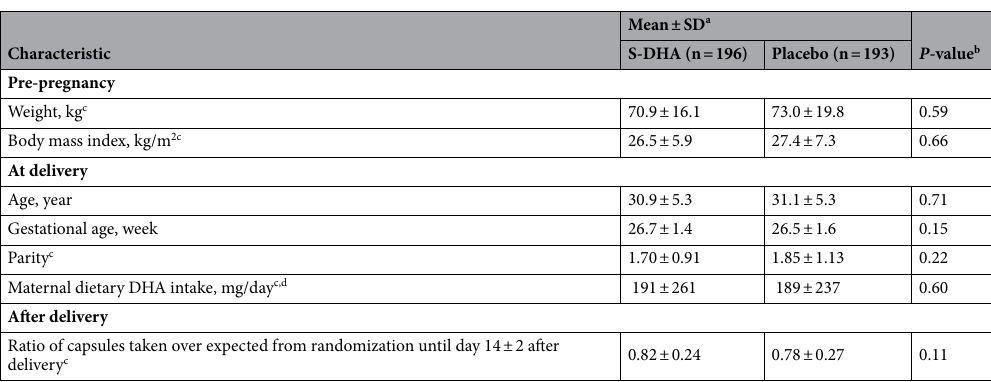
Table 1. Characteristics of mothers whose breast milk samples were analyzed in the group supplemented in DHA (S-DHA) and in the placebo group. DHA docosahexaenoic acid. a Unless otherwise indicated. b P-values were estimated by the Mann–Whitney–Wilcoxon test. c There was missing data (< 10%). d Mean in the last month before